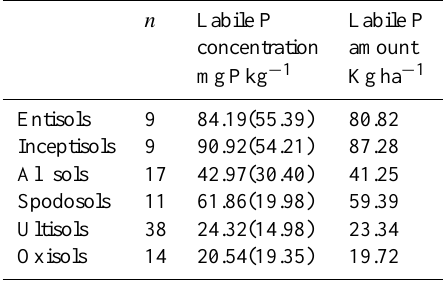
Table 4. Mean (SD) for Hedley-labile P in A-horizons (assumed up to 15cm depth) of soils that typically support forests.